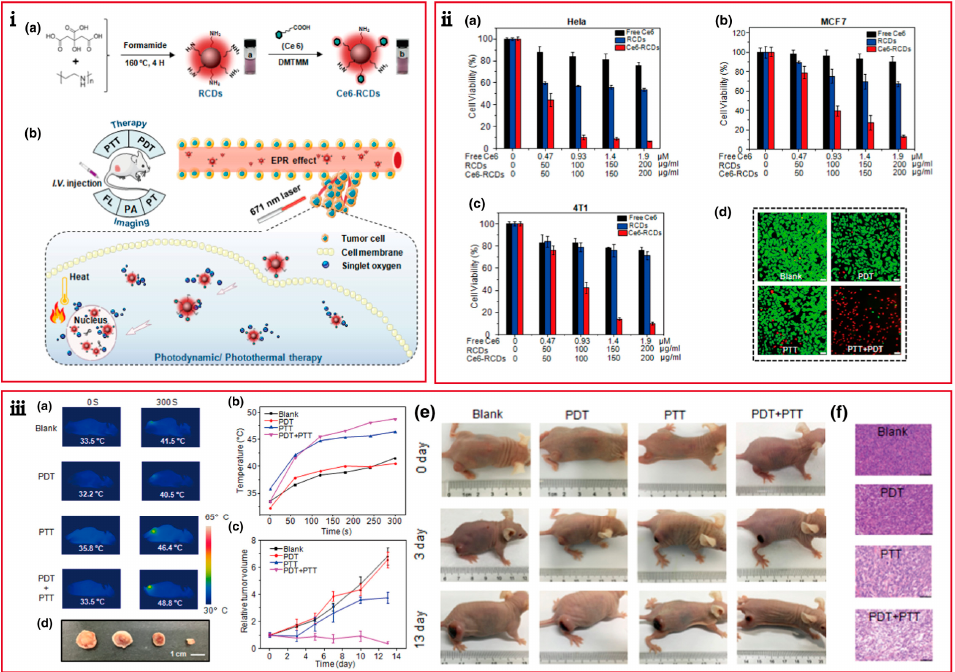
Figure 4. Preparation and PDT in vitro and in vivo of Ce6-RCDs, ( i ) Research schematic diagram of the Ce6-RCDs, ( a ) Schematic diagram of the preparation of the Ce6-RCDs, (b) Schematic illustration of imaging and synergistic PTT/PDT process in vivo. ( ii ) ( a ) HeLa, ( b ) MCF-7, and ( c ) 4T1 cell cytotoxi- city treated by PNCDs of various concentrations, ( d ) Calcein-AM/PI co-staining fluorescence images of Hela cell lines for PDT/PTT estimation. ( iii ) In vivo PDT effect of the PNCDs. ( a ) Thermal images of tumor-bearing mice before and after laser irradiation, ( b ) Temperature elevation curves of tumor regions with laser irradiation time, ( c ) Tumor growth curve recorded from 0 to 13 days, ( d ) Digital photographs of tumors, ( e ) Digital photographs of tumor-bearing mice during the treatment, ( f ) H&E staining of tumors collected from the four group treatments after 1 day. The scale bar is 100 µ m [63]. Copyright 2019, American Chemical